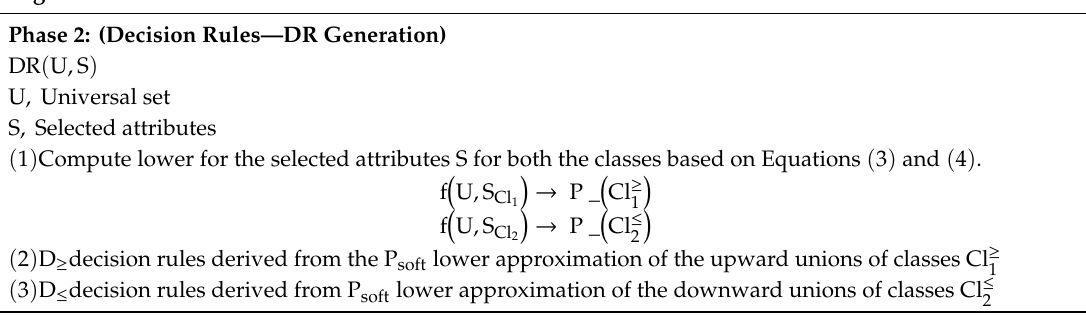
Algorithm 3 Decision Rules